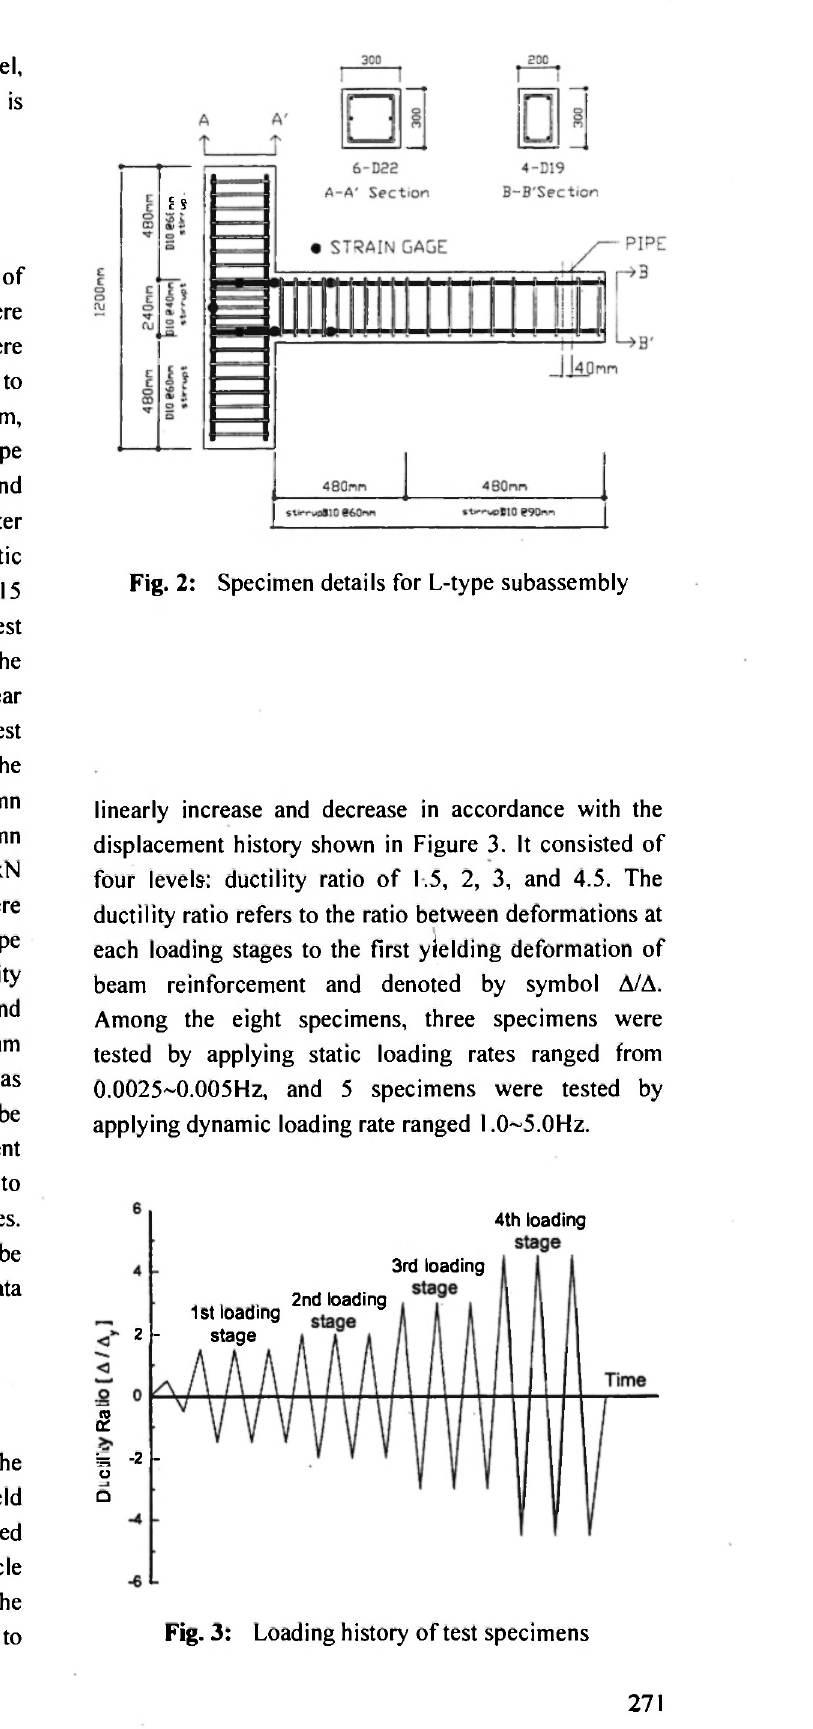
Fig. 3: Loading history of test